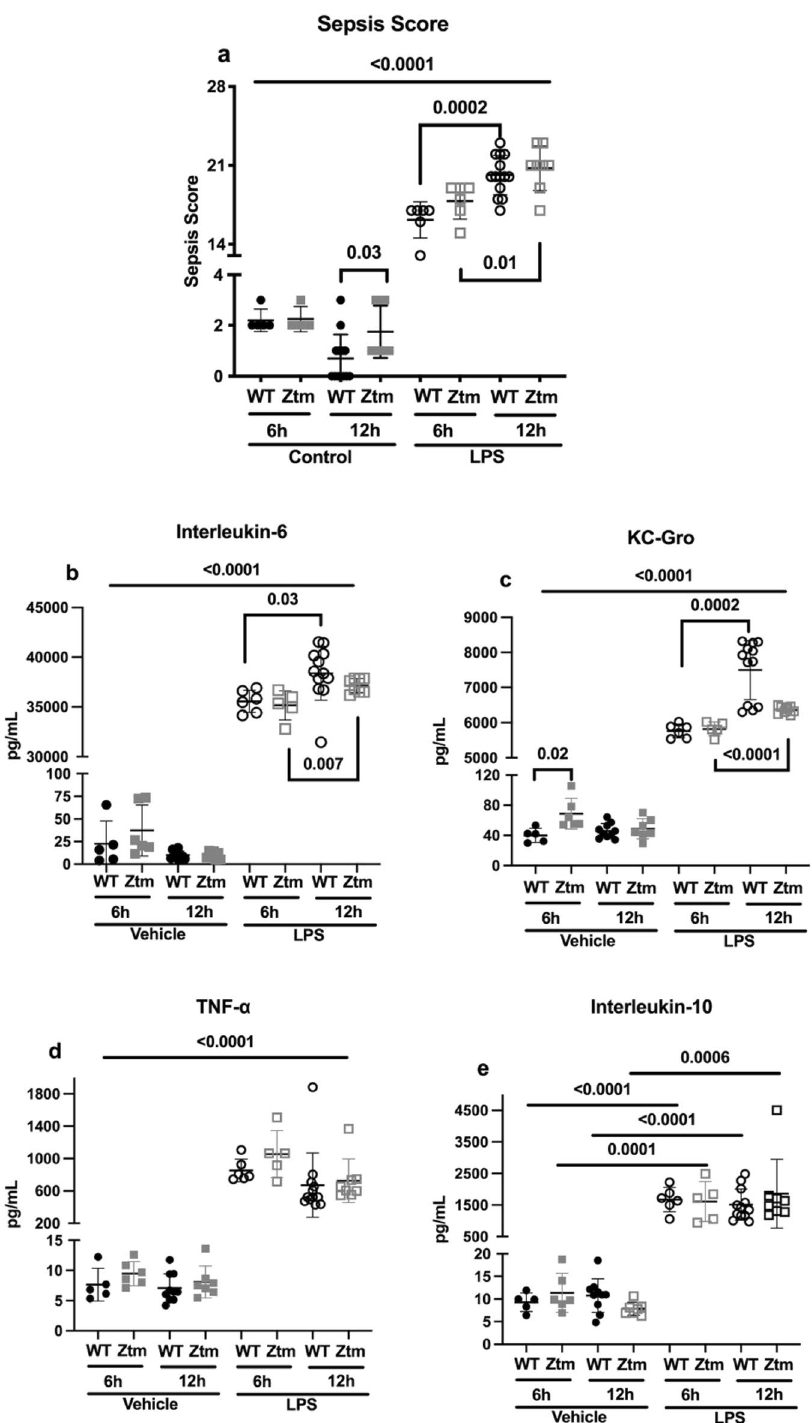
Figure 2. Inflammatory response to LPS 6 and 12 h after injection in wildtype, C57Bl/6 (WT) and zonulin transgenic mice (Ztm). Panel ( a ) Sepsis scores were adjudicated based on ref. 39, 6 or 12 h after vehicle or LPS injection. Panels ( b – e ) Serum levels of IL-6, KC-Gro, TNF-α, and IL-10 were measured using multiplex assay. Individual values per mouse are represented for all assays. Student t test, p < 0.05. Long bars represent the statistical analysis between vehicle- and LPS-injected mice within each genotype. Filled circles—WT vehicle- injected; Filled squares—Ztm vehicle-injected; Open circles—WT LPS-injected; Open squares—Ztm LPS- injected.